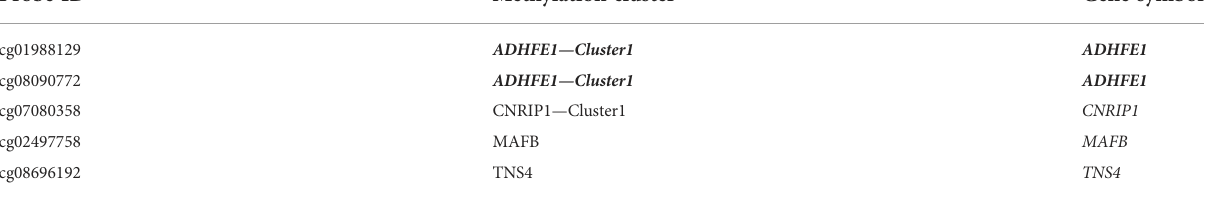
TABLE 1 Information on iRFE